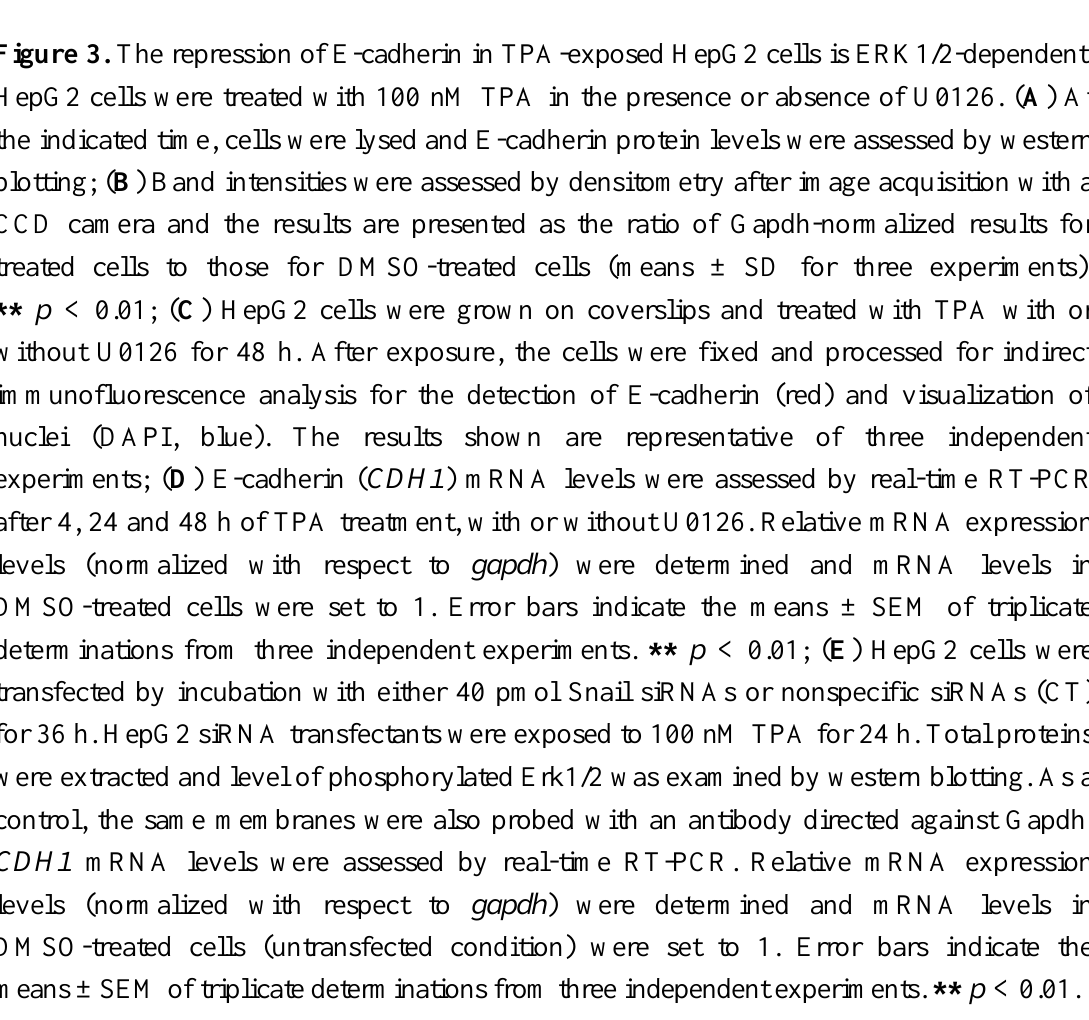
Figure 3. The repression of E-cadherin in TPA-exposed HepG2 cells is ERK1/2-dependent. HepG2 cells were treated with 100 nM TPA in the presence or absence of U0126. ( A ) At the indicated time, cells were lysed and E-cadherin protein levels were assessed by western blotting; ( B ) Band intensities were assessed by densitometry after image acquisition with a CCD camera and the results are presented as the ratio of Gapdh-normalized results for treated cells to those for DMSO-treated cells (means ± SD for three